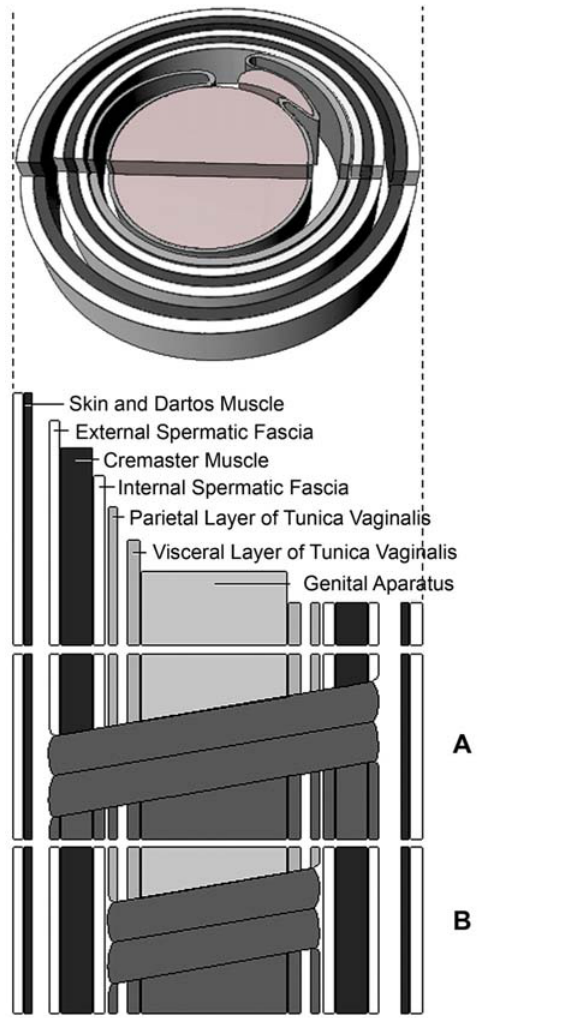
Figure 4 – Diagrammatic illustration of scrotal membrane layers outside genital apparatus (testis, epididymis, sper- matic cord and spermatic vessels) and proposed anatomi- cal explanations of extravaginal torsion (EVT). Ischemic tissues under torsion are demonstrated by the same color. A)- EVT outside cremaster muscle. B)- EVT inside cre- master